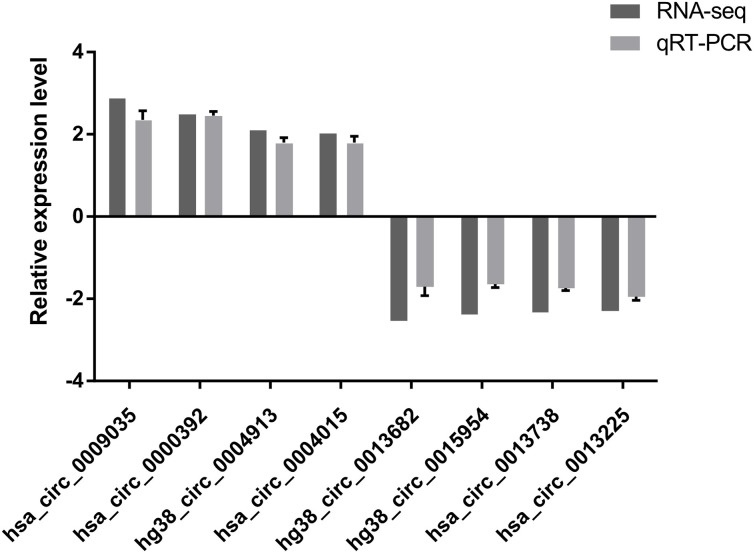
qRT-PCR results.The expression patterns of the top four up-regulated and top four down-regulated circRNAs as monitored by qRT-PCR. The expression patterns of these eight circRNAs determined by qRT-PCR agreed with the results of the high-throughput sequencing analysis and demonstrated the reliability of the RNA high-throughput sequencing technology.